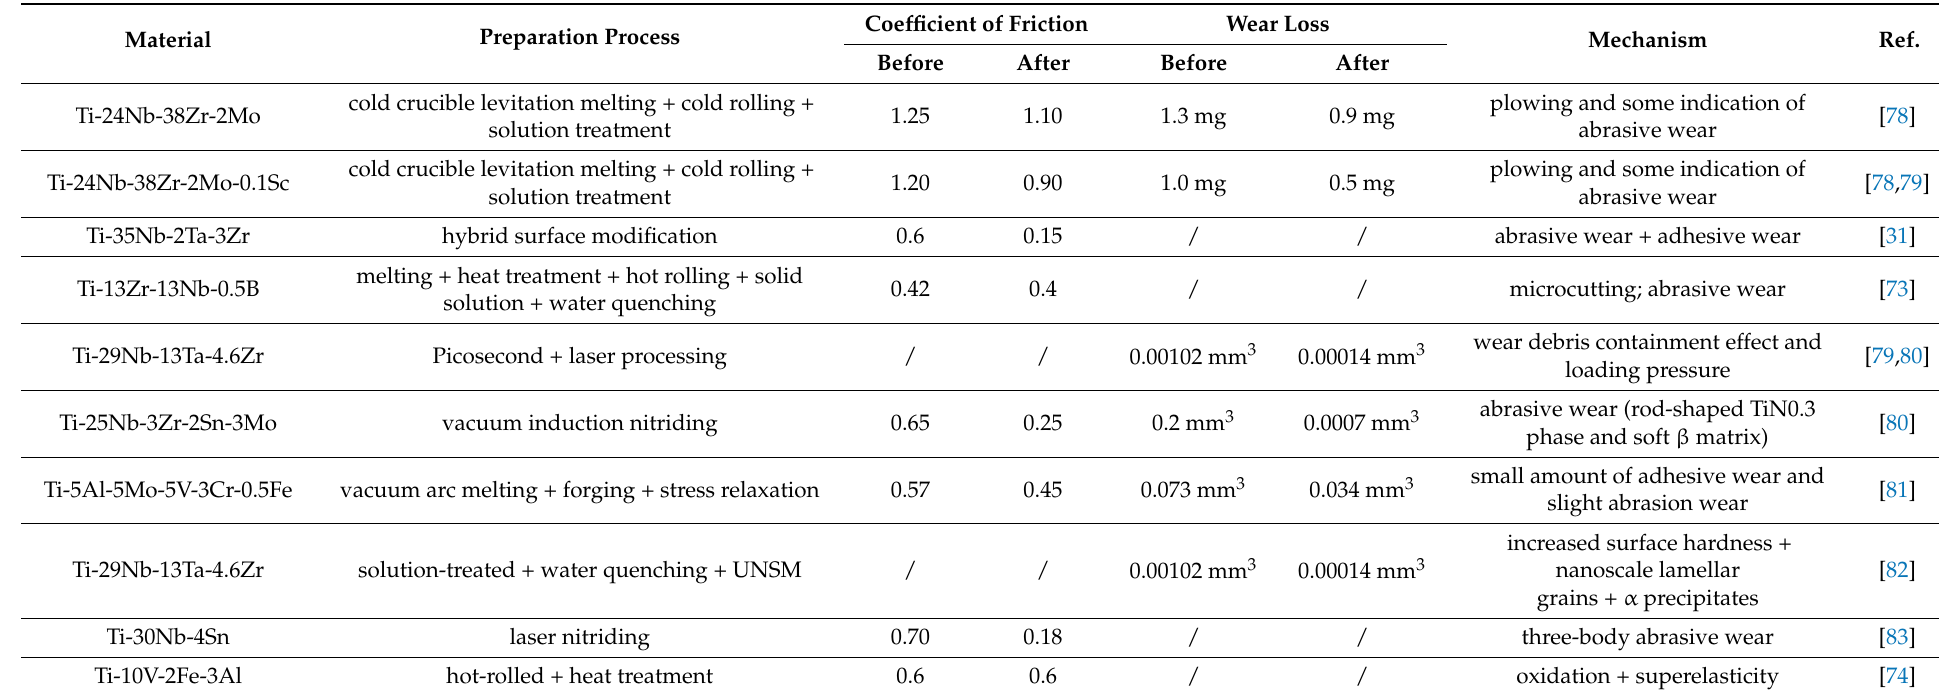
Table 2. Summary of preparation process and tribological